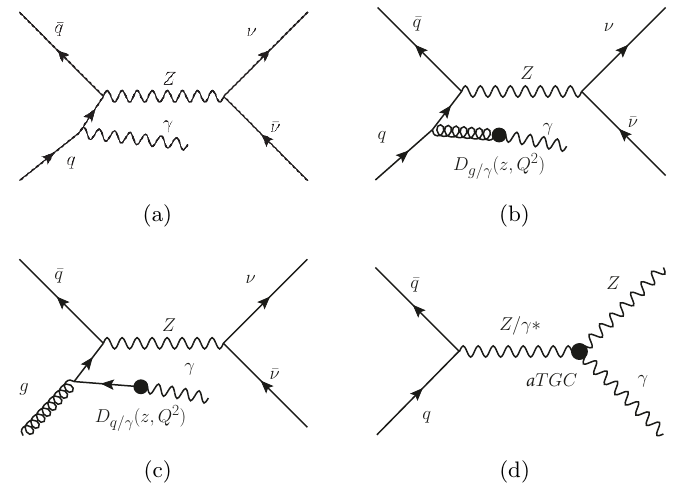
Figure 1 . Feynman diagrams of Z ( (cid:23) (cid:22) (cid:23) ) (cid:13) production: (a) initial-state photon radiation (ISR); (b,c) contributions from the Z + q ( g ) processes in which a photon emerges from the fragmentation of a quark or a gluon; and (d) an aTGC